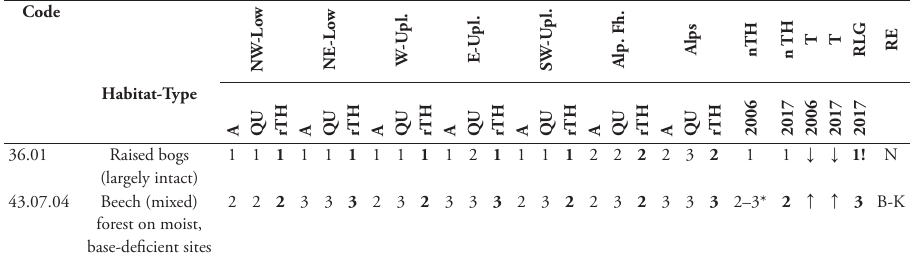
Table 6. Red List assessment for ‘raised bogs’ and Beech (mixed) forest in 2017. Regional Red List cat- egories are presented for all major landscape regions. Code – hierarchical coding for database applications; A – Areas Loss; QU – Quality Loss; rTH – Regional Long-term Threat; nTH – National Long-term Threat; T – Current Trend; RLG – German Red List status; RE – Regeneration Ability: B-K – regenera- tion ‘conditionally possible’ to ‘hardly possible’; N – ‘not regenerable’; Major landscape region (see Blab et al. 1995): NW-Low – North-western lowlands; NE-Low – North-eastern lowlands; W-Upl. – Western highlands; E-Upl. – Eastern highlands; SW-Upl. – South-western highlands; Alp. Fh. – Alpine foothills; Alps – Alps * intermediate values are no longer used for nTH in